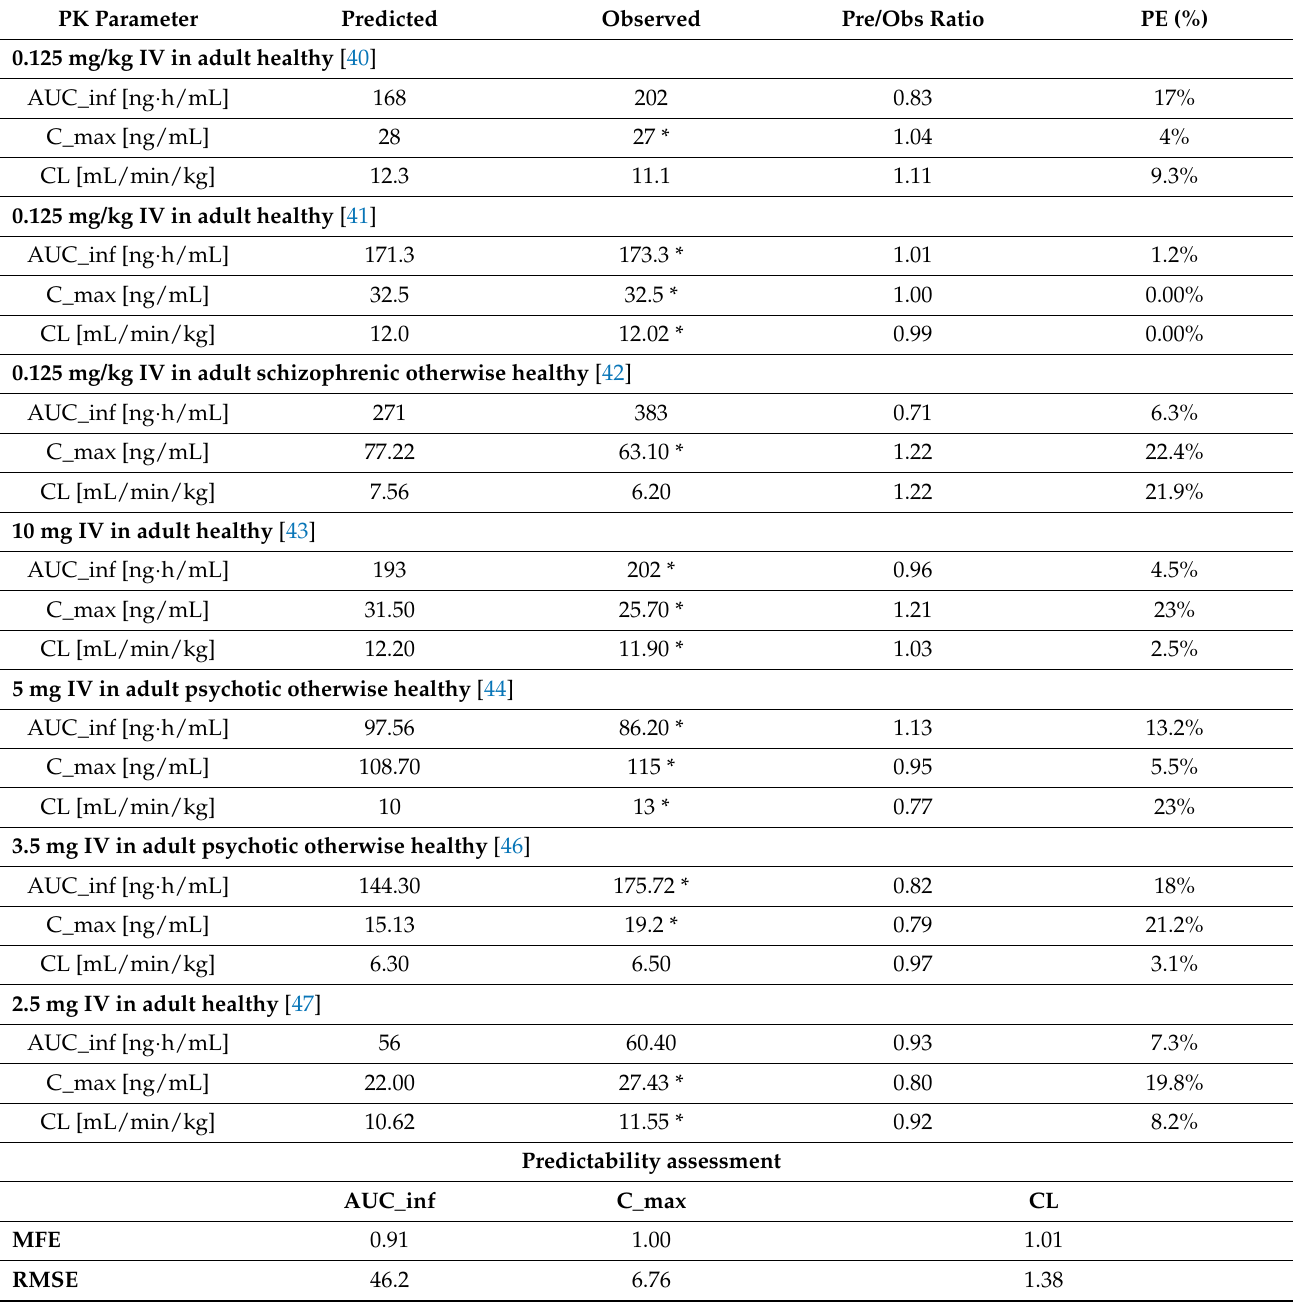
Table 4. Pharmacokinetic analysis of predicted and observed values in adult healthy and psychotic otherwise healthy populations after intravenous